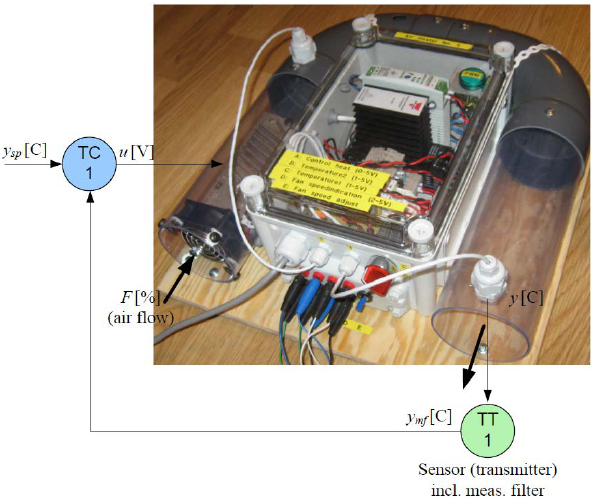
Figure 6: Temperature control system for an air heater (laboratory rig)